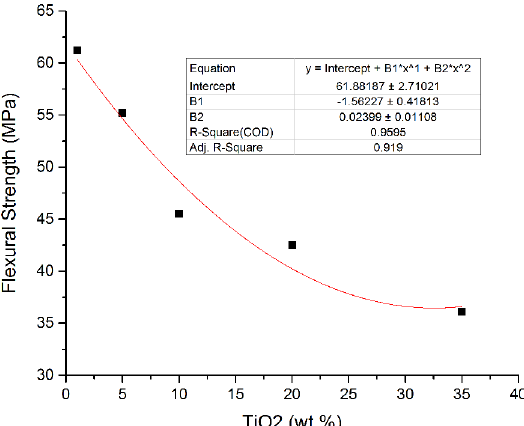
/ABS composites 2